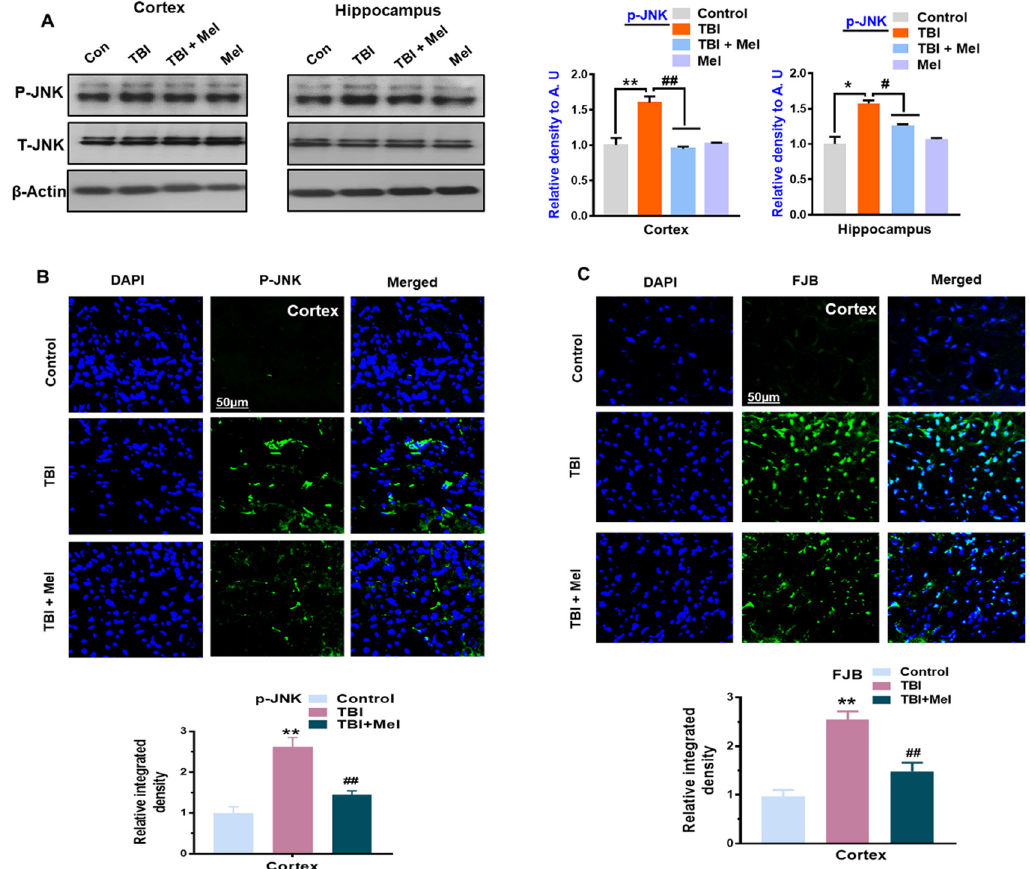
Figure 4. Melatonin modulates the expressions of c-Jun N-terminal kinase (p-JNK) and enhances cell survival in the repetitive mild traumatic brain injury (rmTBI)-mouse model. ( A ) Representative immunoblots and histograms showing p-JNK expressions in the cortex and hippocampus of the experimental groups, with bar graphs. n = 10 mice per group. The beta-actin antibody was used as